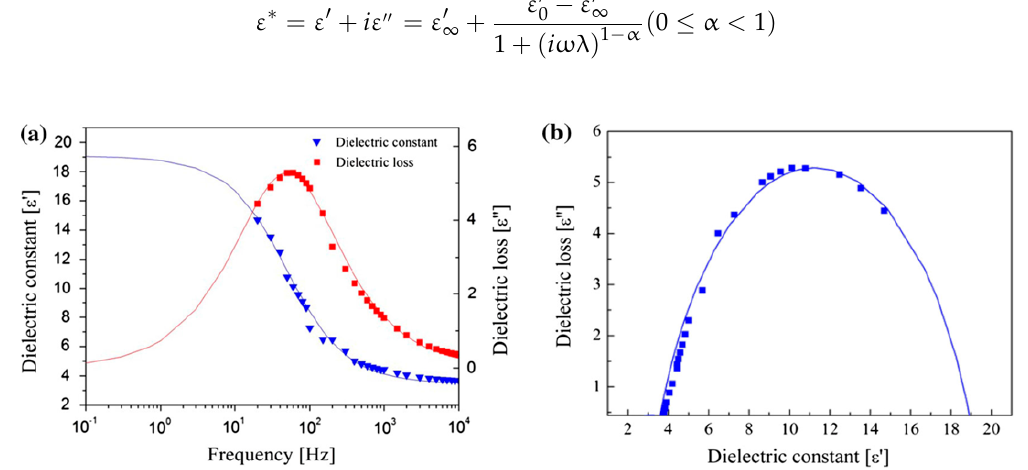
Figure 13. Dielectric properties of an MCC particle based ER fluid: ( a ) dielectric constant and loss factor vs. frequency; and ( b ) dielectric loss vs. dielectric constant (Cole–Cole plot) [93]. Here, ε 0 is the relative permittivity when the frequency is near 0, and ε ∞ is the dielectric value when the frequency is infinite [111]. The difference between these values, ∆ε = ε 0 − ε ∞ , represents the polarizability of the ER fluids, which is related to the electrostatic interactions between the conducting particles. The index (1 − α ) represents the broadness of the relaxation time distribution. The relaxation time of λ = 1/2 π ƒ max is the speed of interfacial polarization in the presence of an electric field, in which the ƒ max represents the maximum ε ”. In this study of the MCC based ER fluid, the values of the parameters of ε 0 , ε ∞ , α , and λ were 19.1, 3.52, 0.245, and 0.0032, respectively, revealing a very